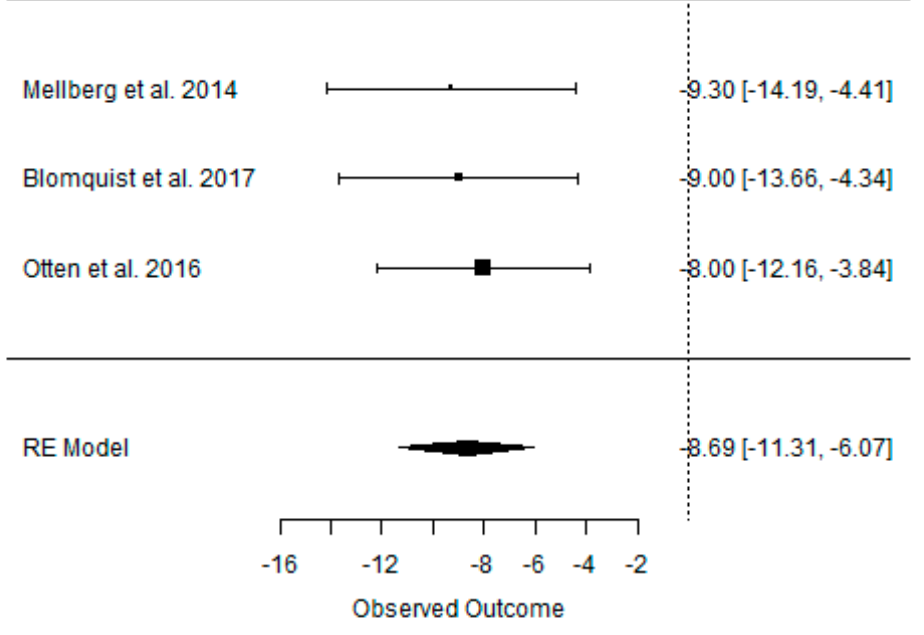
Figure A11. Forest plot of the effect of a CD on BM (kg) in the long term (weighted mean difference).